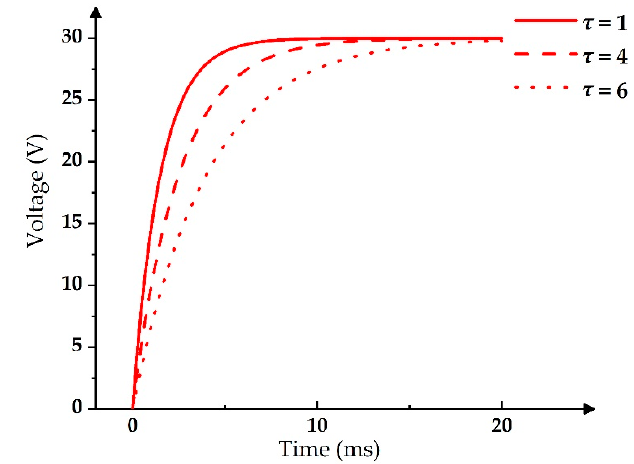
Figure 4. Exponential functions with different τ values.